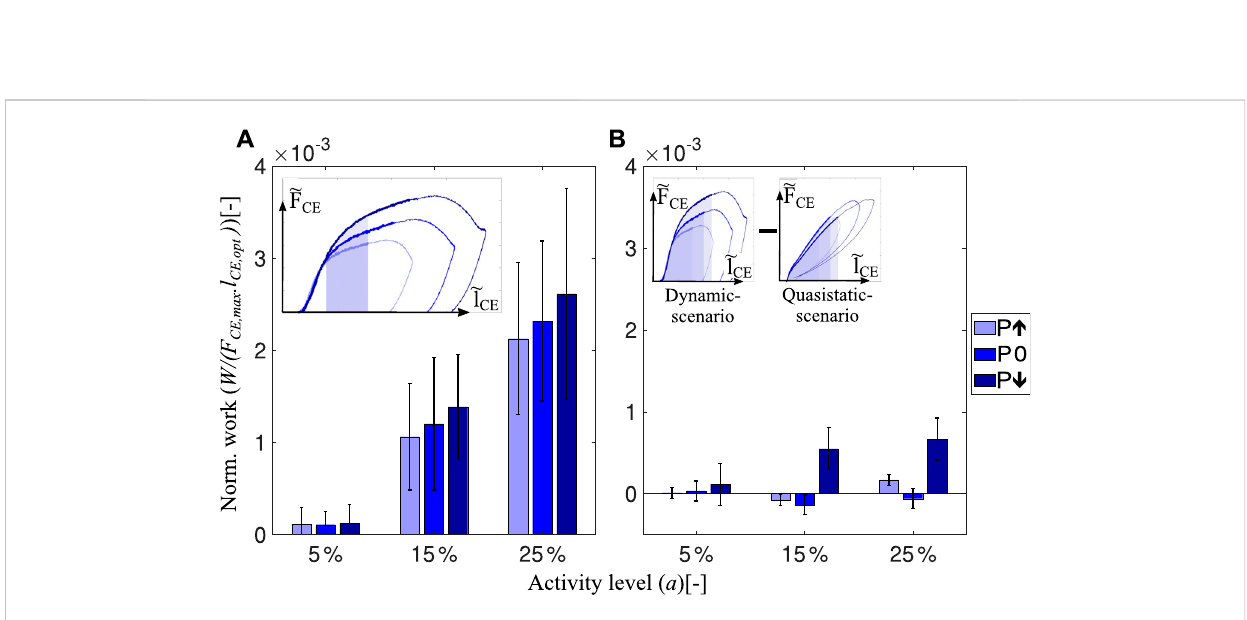
FIGURE 5 In fl uence of velocity adaptation on pre fl ex work is represented. (A) shows the dissipated energies at dynamic-scenario experiments after the short- rangestiffnesstilltheendofthe ‘ step-up ’ perturbationphase(shadedareashownintheinset).Elasticcontributioniskeptequalforallperturbationstates. Thus, the difference in energy will be caused by the difference in velocity pro fi les. (B) shows the pre fl ex work difference between the dynamic-scenario andquasistatic-scenarioexperimentsforeachperturbationlevel.Thepre fl